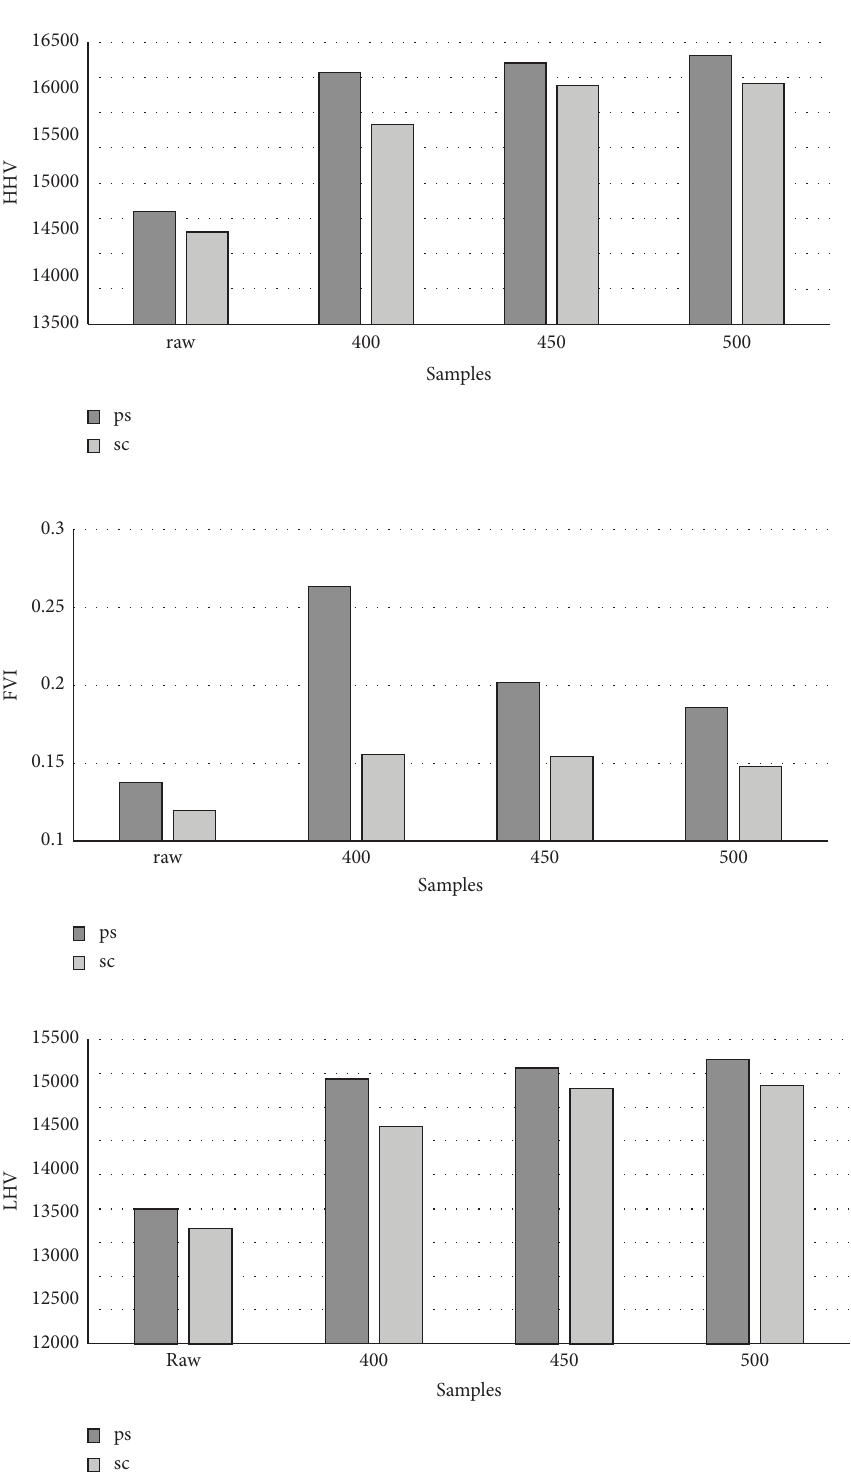
Figure 1: Energy properties of raw and pyrolysis